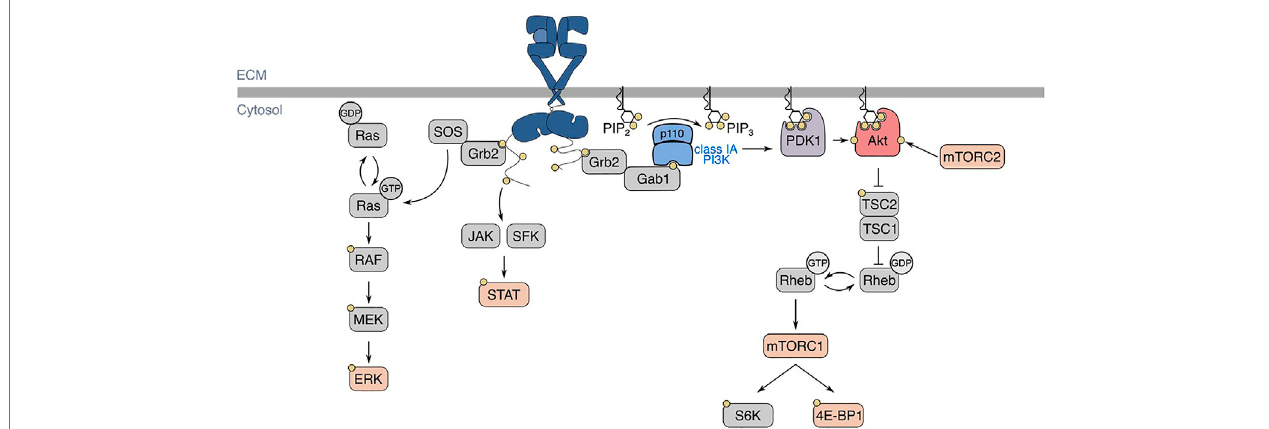
FIGURE2| EGFRstructure,ligand-binding,andsignalingpathways.Inthebasalstate,EGFRexistsinanautoinhibitedconformation.Ligand-bindingallowsforthe formation of homo- or heterodimers, which activates EGFR intrinsic tyrosine kinase domains and ensues signal transduction, shown here as an EGFR homodimer with one ligand bound. Various signalling pathways are initiated by the active EGFR, such as Ras-Erk, JAK/SFK-STAT, and PI3K-Akt. Regarding EGFR-PI3K-Akt signalling, EGFRautophosphorylationatY1068allowsfortheactivationofclassIAPI3K.TheactivePI3KsubsequentlyphosphorylatesPI(4,5)P 2 (PIP 2 )intoPI(3,4,5)P 3 ,which recruitskinasesPDK1andAkttotheplasmamembrane.There,AktisphosphorylatedbyPDK1andmTORC2atT308andS473,respectively.EGFR:epidermalgrowth factor receptor, JAK: Janus kinase, SFK: Src-family kinase, STAT: signal transducer and activator of transcription, PI3K: phosphoinositide 3-kinase, PDK1: phosphoinositide-dependent kinase 1, mTORC: mechanistic target of rapamycin complex, TSC: tuberous sclerosis complex, SOS: son of sevenless, Grb2: growth factor receptor-bound protein 2, Gab1: Grb2-associated binding protein